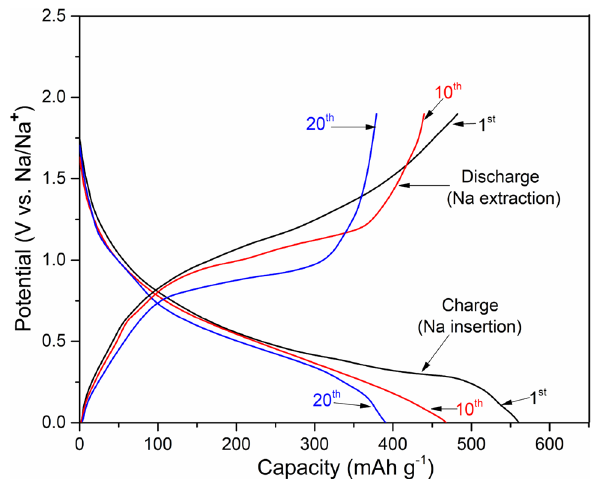
Fig. 3 Charge and discharge profiles of SnO–V2O5–SiO2 glass anode